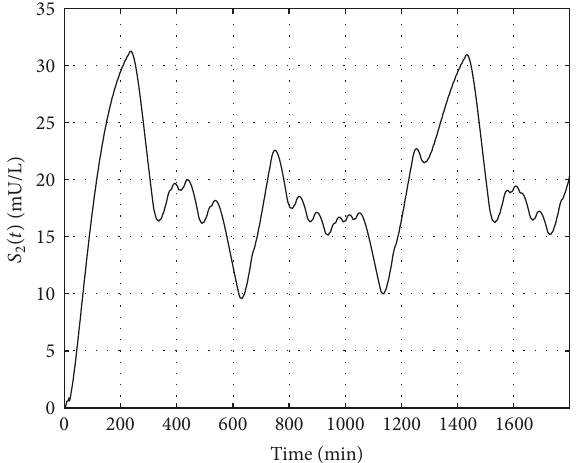
Figure 4: Variation of the second state of the glucose absorption subsystem.